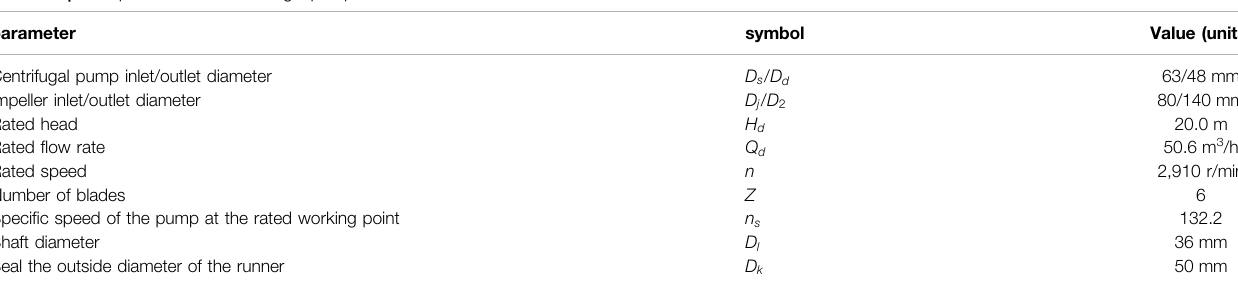
TABLE 1 | Main parameters of centrifugal